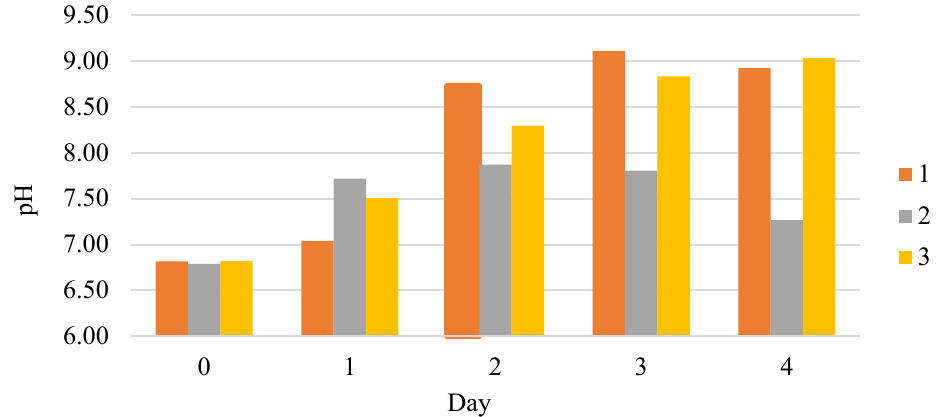
Figure 3. Additive effects on the pH dynamics of C. vulgaris cultivation: 1, control (no additives); 2, added H 2 O 2 ; 3, added H 2 O 2 + pyridoxin. In order to compare homogeneous groups in the determination of pH, one-factor dispersing analysis and F-criteria analysis were used. A significant difference was found between the compared groups (F was significantly greater than 1), which was assessed at p < 0.05.